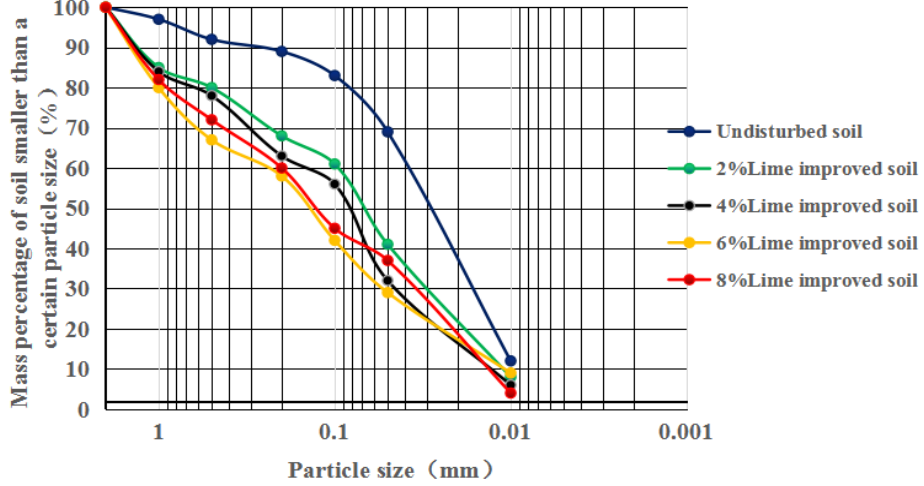
Figure 5. Particle gradation curve of lime-modified soil with different dosages.